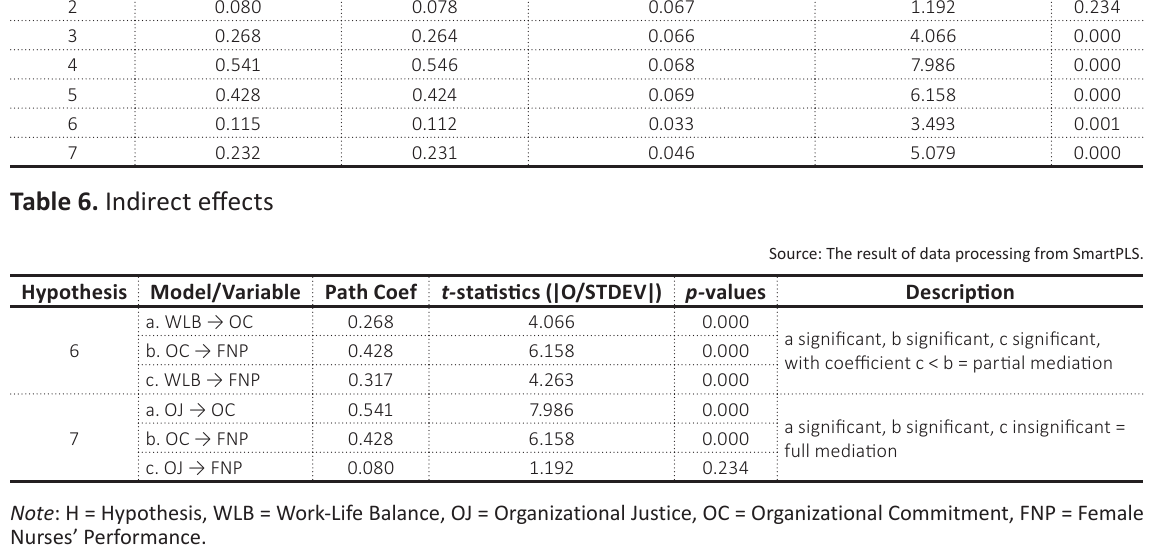
Source: The result of data processing from SmartPLS.